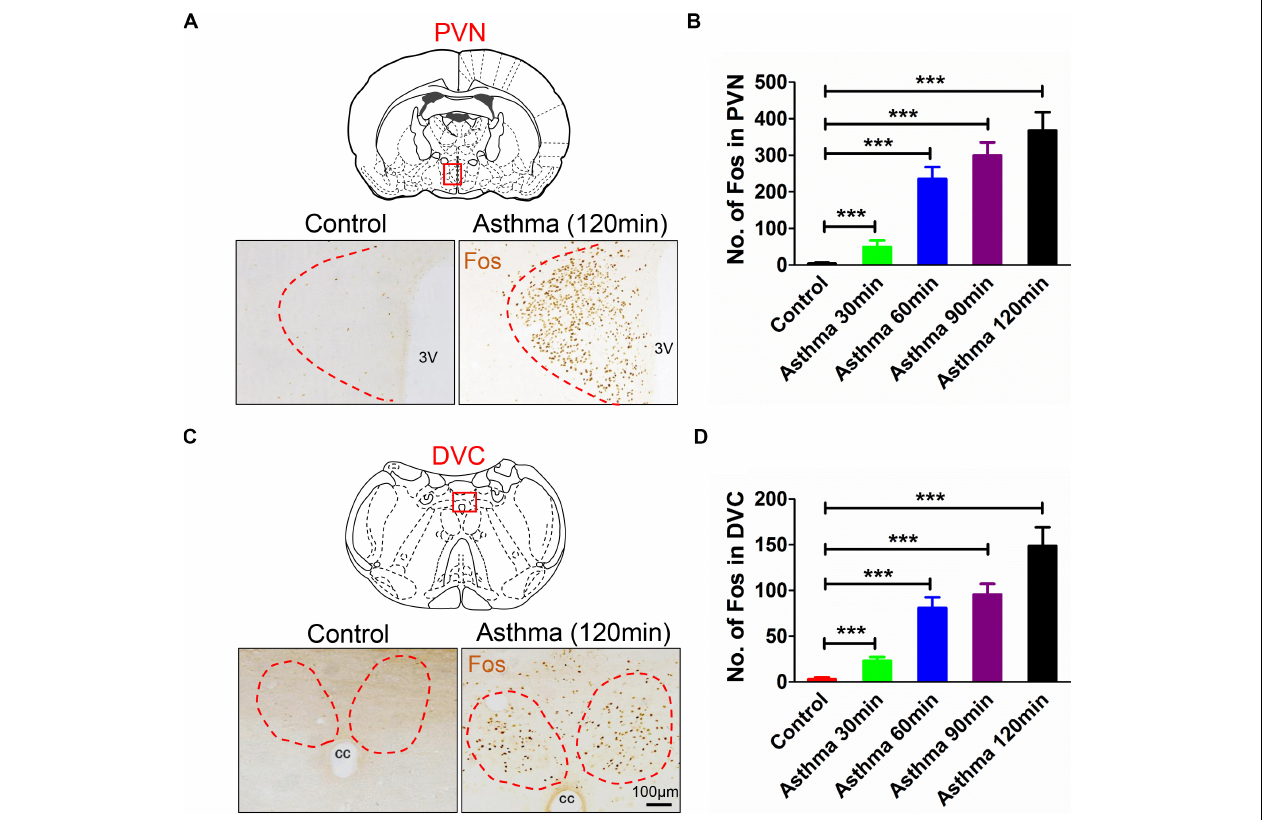
FIGURE 2 | (A) Fos expressions in PVN in asthma and control rats. (B) Counts of Fos-positive neurons in PVN in control and asthma (30, 60, 90, and 120 min) rats. (C) Fos expressions in DVC in asthma and control rats. (D) Counts of Fos-positive neurons in DVC in control and asthma (30, 60, 90, and 120 min) rats. The nucleus of the Fos-positive neurons was brownish yellow staining, and Fos expressions increased gradually in the 30, 60, and 90 min and peaked at the 120 min. *** p < 0.001. n = 6 per group. PVN, paraventricular nucleus; DVC, dorsal vagal complex; 3V, third ventricle; cc, central canal.